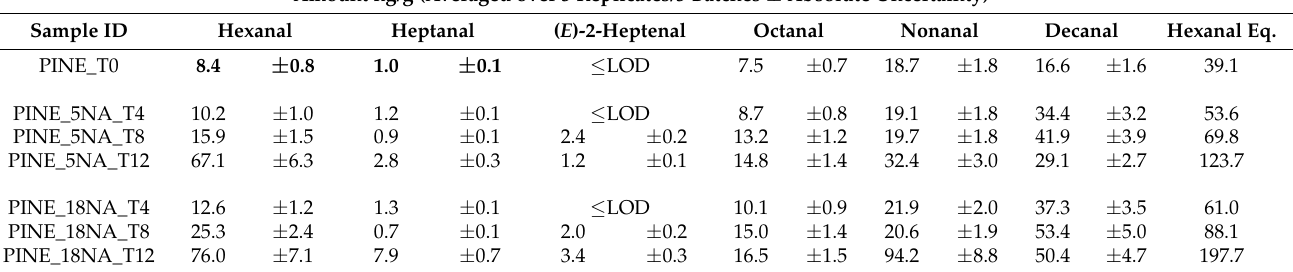
Table 6. Amounts expressed as ng/g for quantified targeted aldehydes in dried pineapple samples. In bold analytes whose concentration exceeds the OTs (OAV > 1).